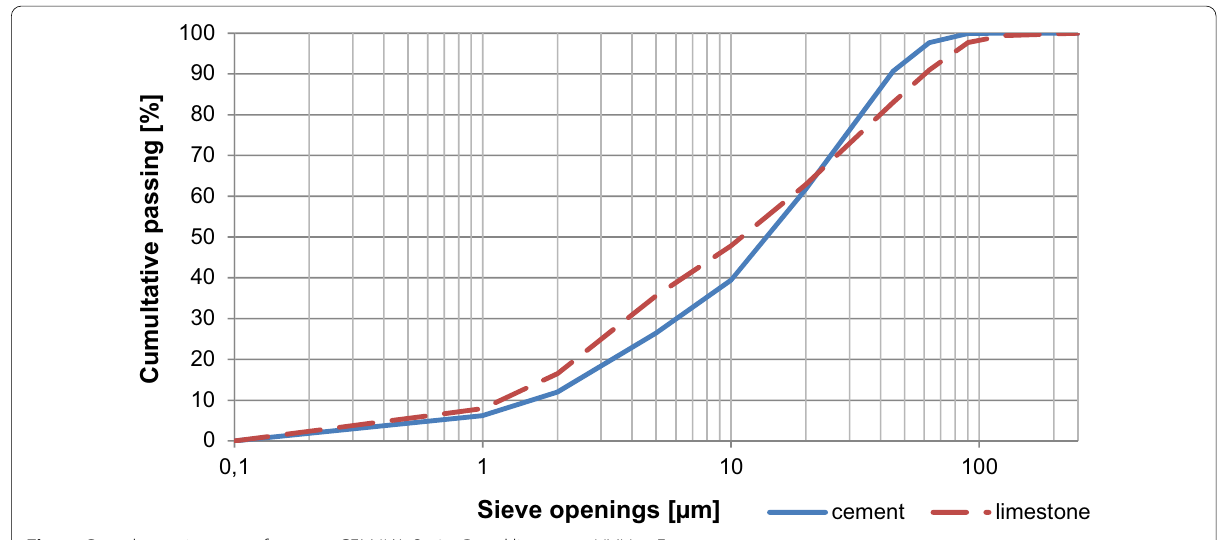
Fig. 1 Granulometric curve of cement CEM II/A-S 42,5 R and limestone VMV15-F